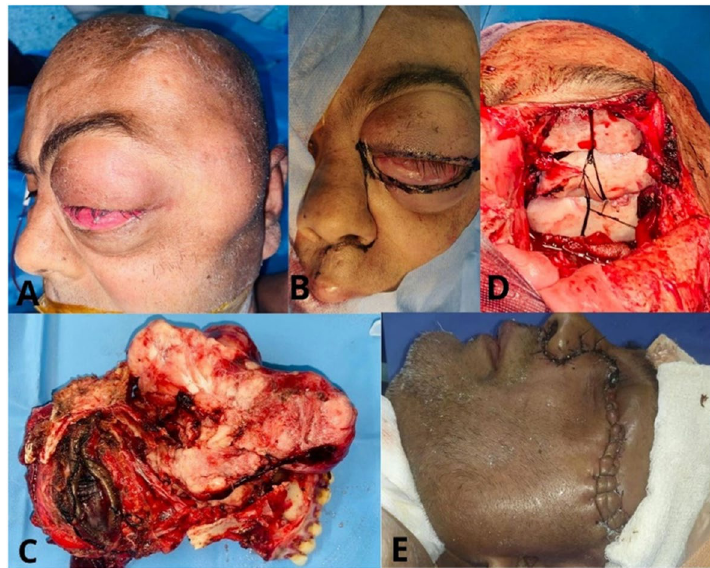
Fig. 1 The clinical picture of the patient. A Proptosis with large lobulated swelling of the left temporal region. B Modified Weber-Fergusson incision marked. C Specimen after excision of the tumour (total maxillectomy with orbital exenteration). D Reconstruction of the skull base. E Post-operative image after suturing